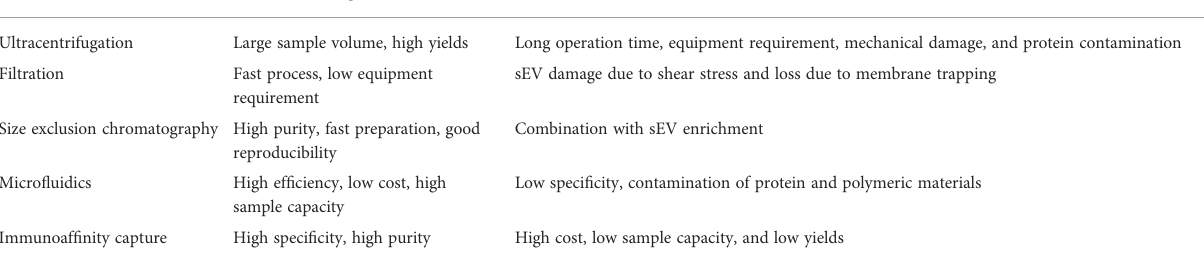
TABLE 1 Comparison of separation technologies of